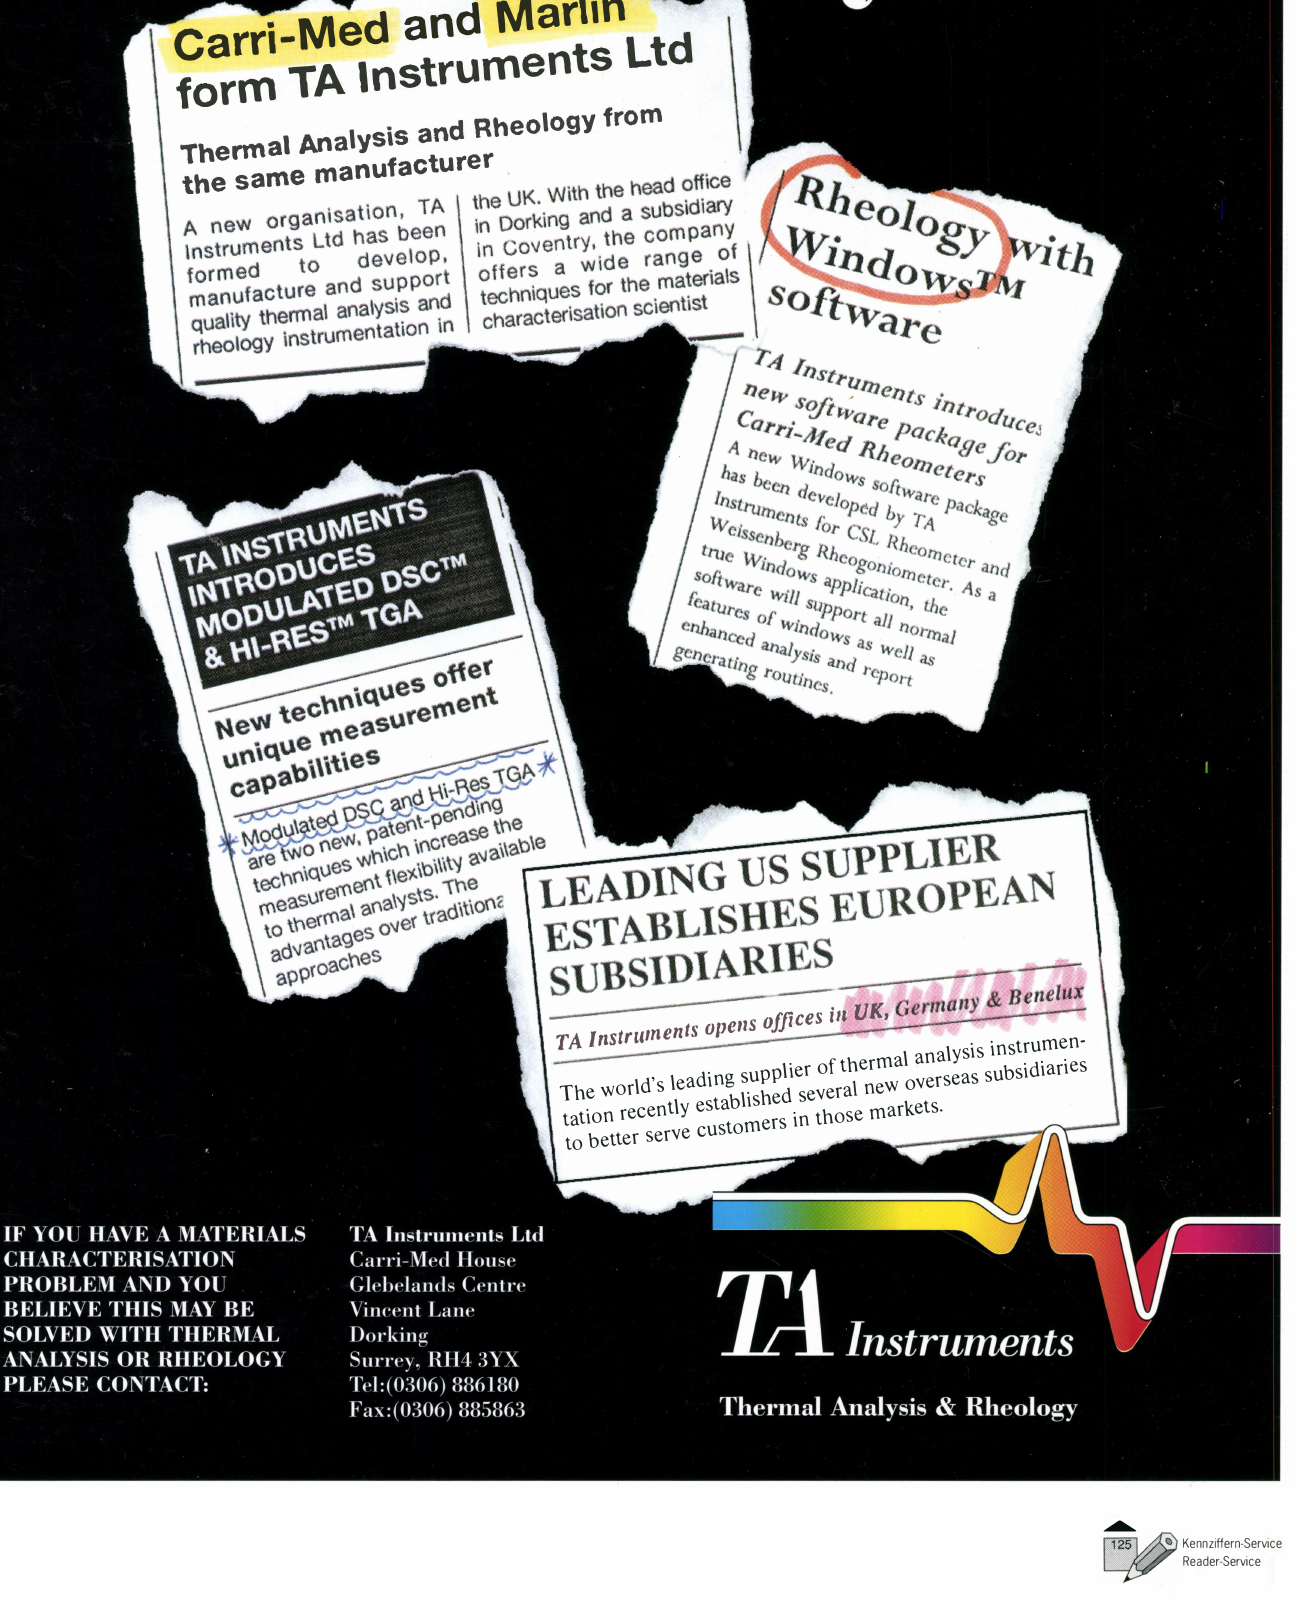
Rheolo g y f ro m ysis and Therm a l A n a l anu fac t the same m